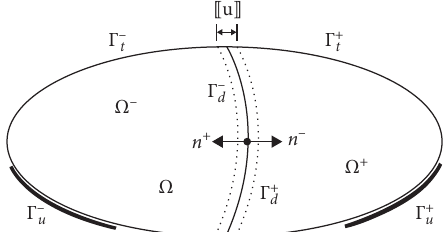
Figure 8: Continuum solid divided by the discontinuity Γ